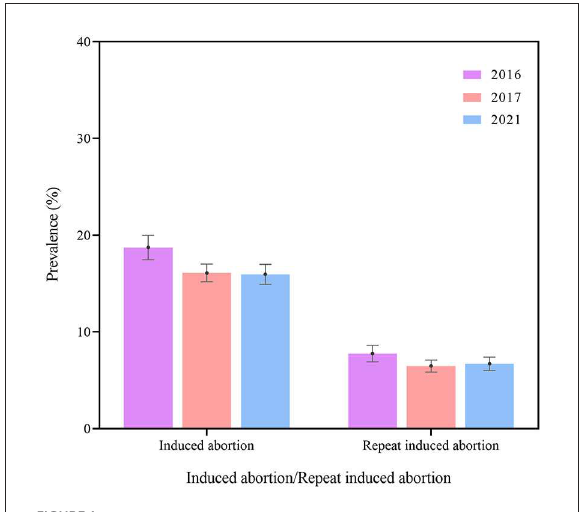
FIGURE1 The prevalence of induced abortion and repeat induced abortion among Chinese women in 2016, 2017, and 2021.